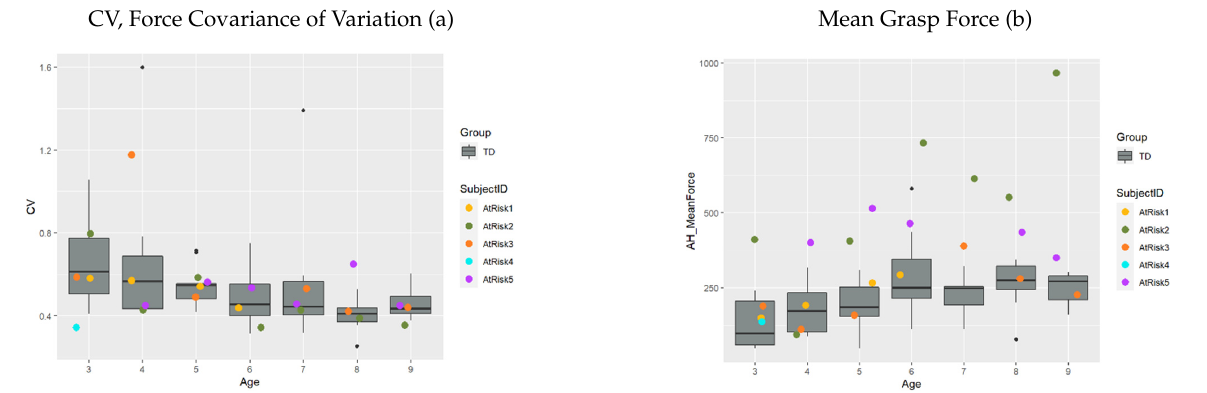
Table 4. HUGS ‐ 2 (at ‐ risk) versus HUGS ‐ 1 (TD) grasp force change over time. CV, Force Covariance of Variation (a) Mean Grasp Force (b)